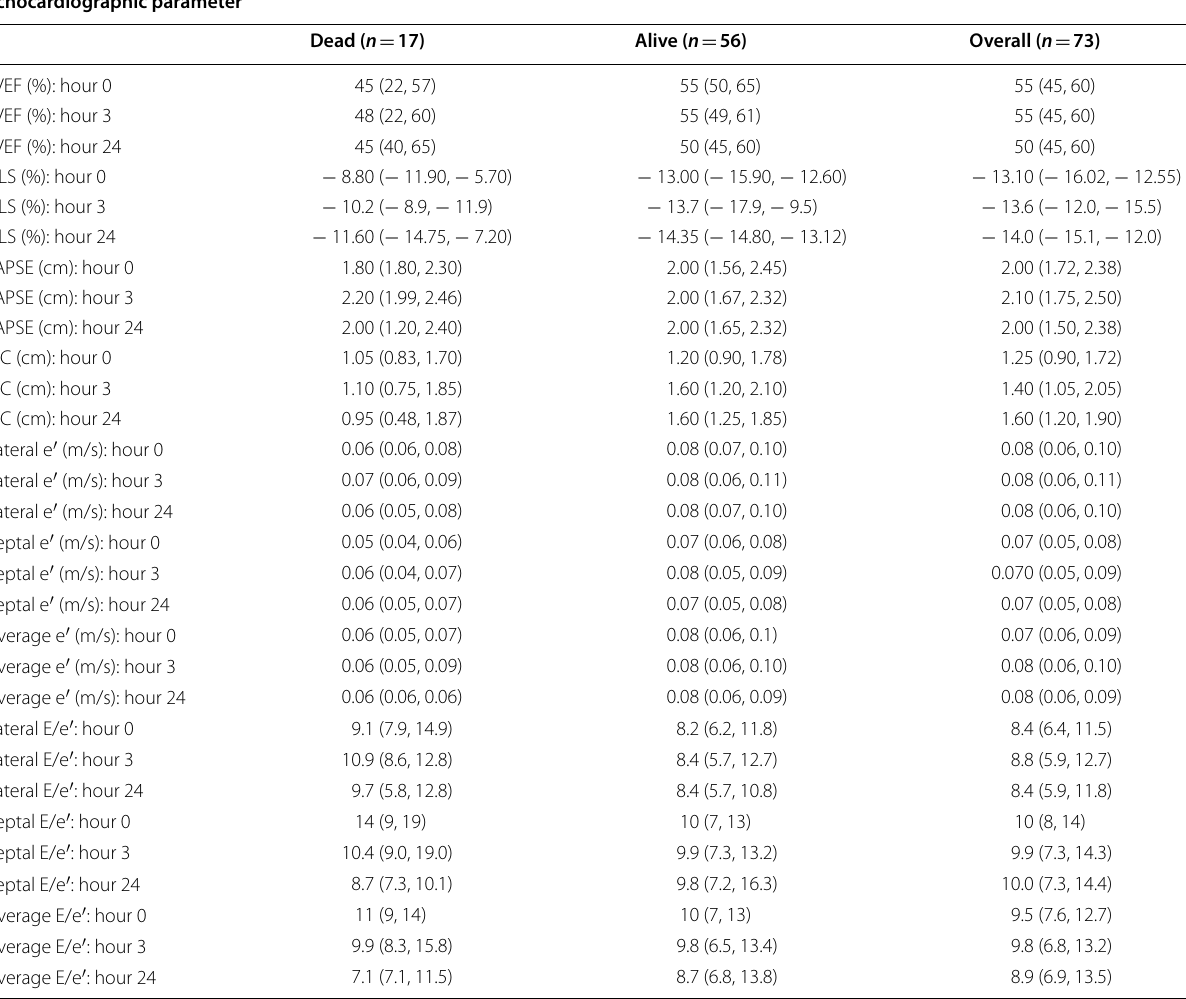
Data are presented as median value (Q1, Q3) at each timepoint, with each cell representing an independent measurement (i.e., no within-subject correlation) LVEF left-ventricular ejection fraction; GLS global longitudinal strain; TAPSE tricuspid annular plane systolic excursion; IVC maximal diameter of the inferior vena